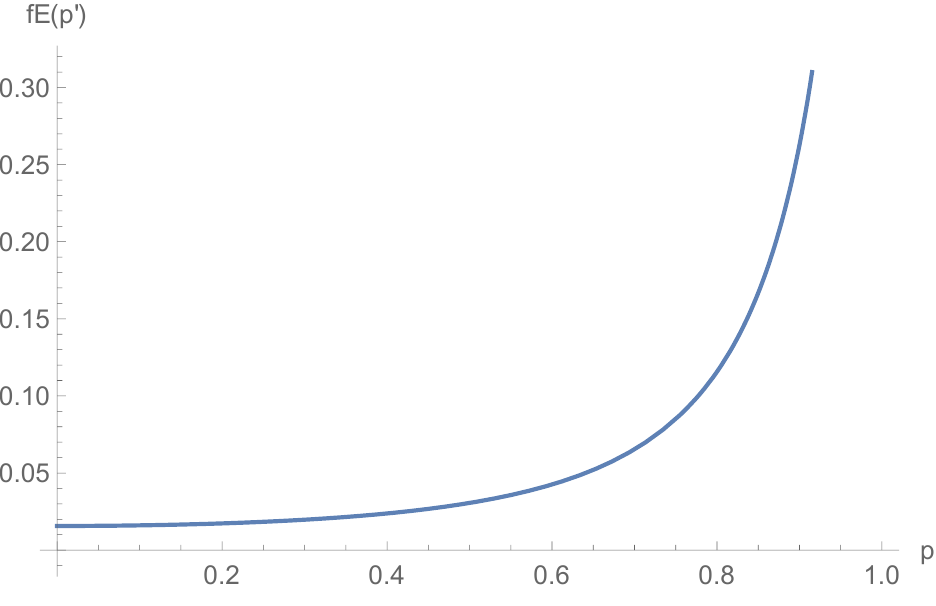
Figure 18. Probability density function for a free Euclidean particle as function of p (cid:48) for λ =